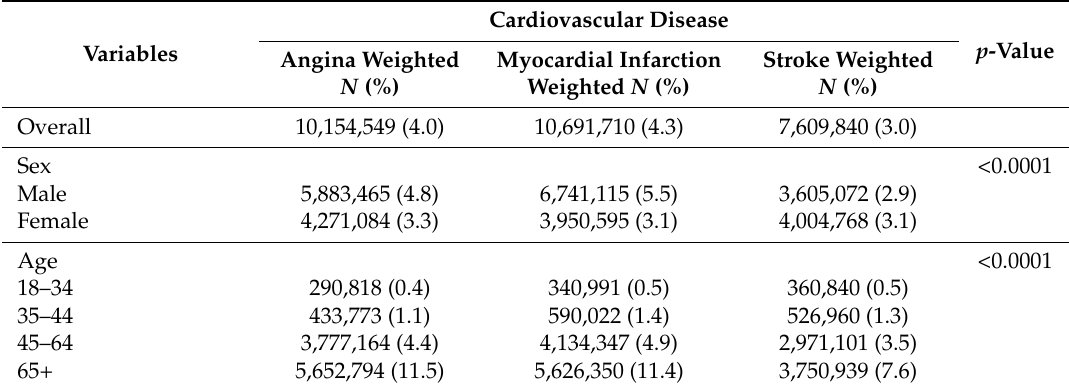
Table 2. Weighted percentages of respondents with cardiovascular disease: BRFSS